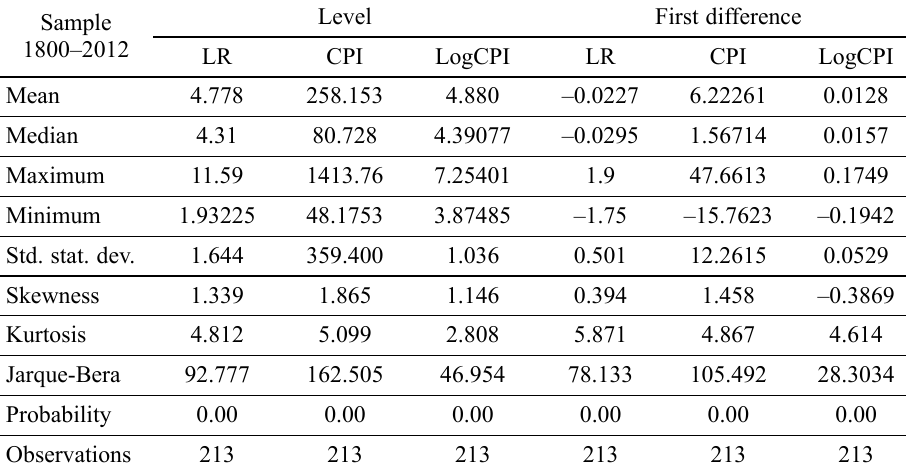
Table 1. Time series descriptive